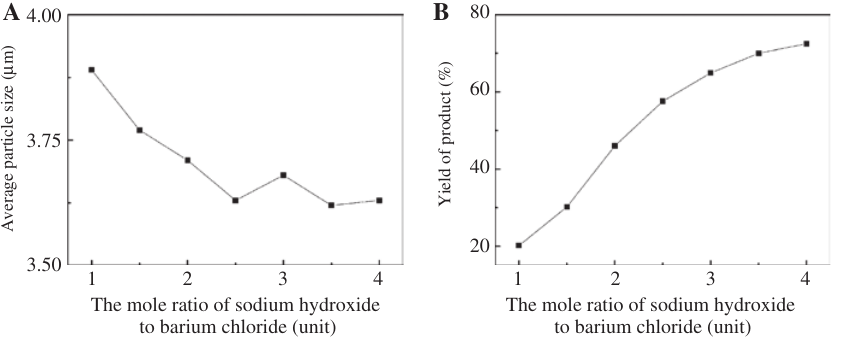
Figure 4: Effect of NaOH concentration on average particle size (A) and yield of product (B), respectively, in the homogeneous